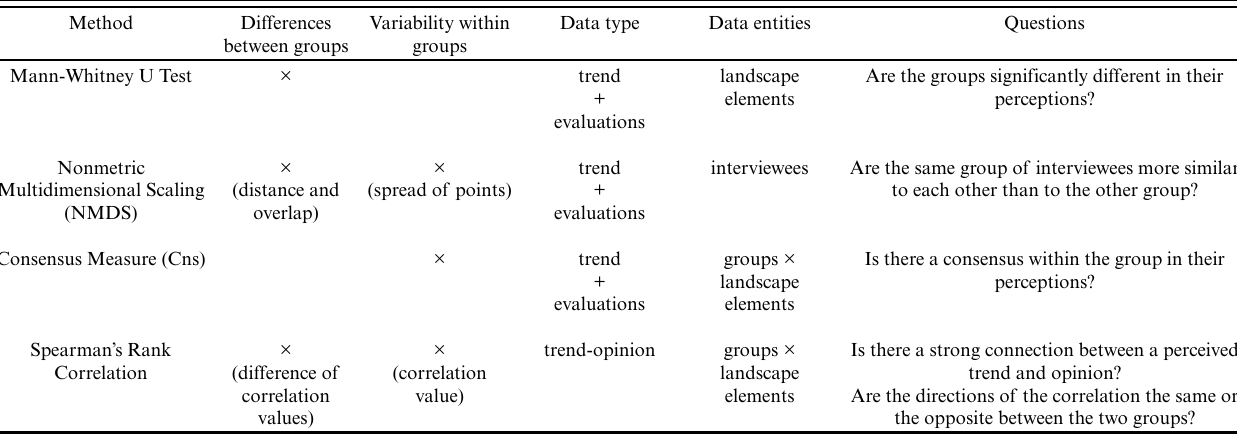
Table 1 . Applied statistical methods and their connections to our research questions concerning between-group differences and within- group